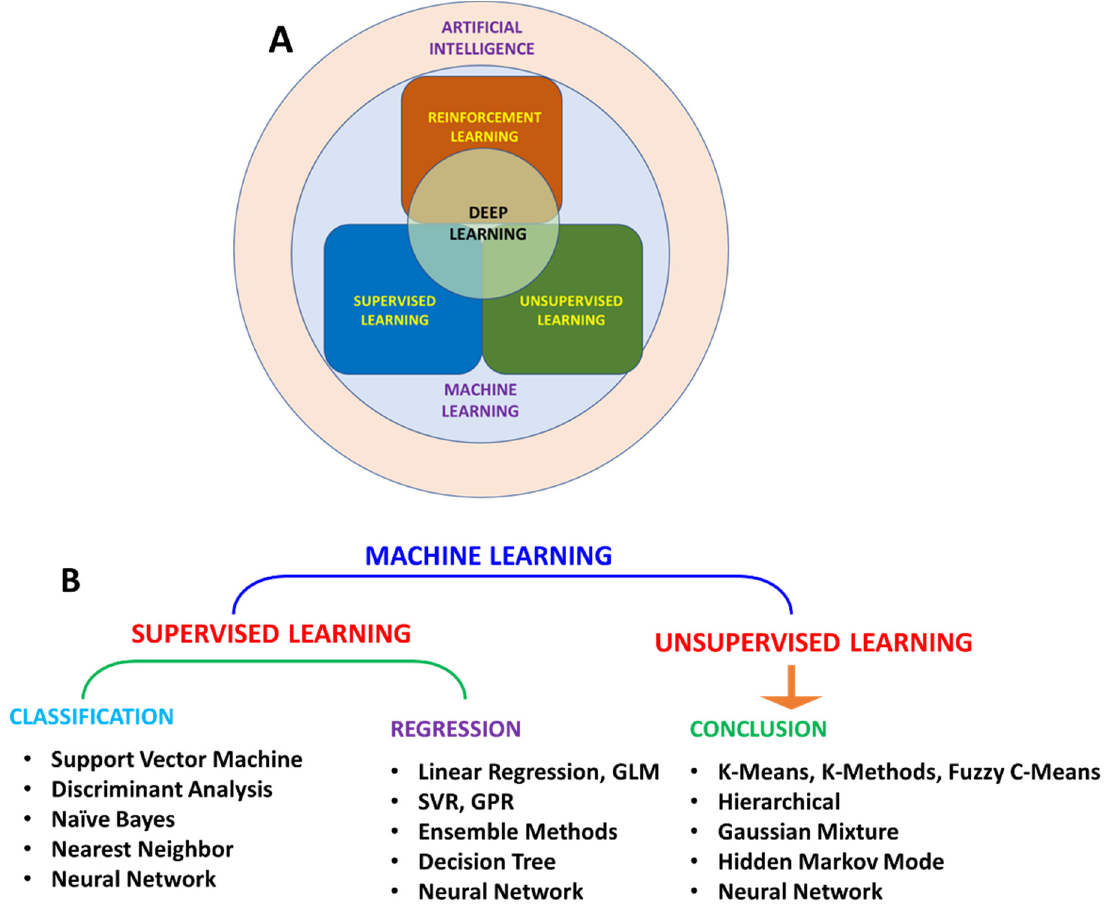
Figure 2. Schematic representation of relation between AI, ML, and DL ( A ); classification of ML algorithm ( B ).